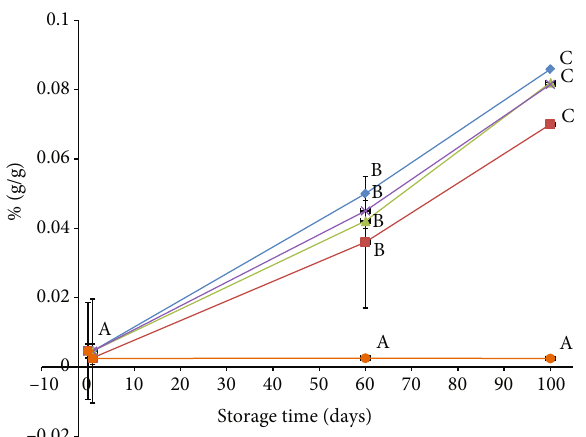
Figure 4: Melanin concentration (%) obtained by the di ff erent preservation methods during storage ( P value < 0.05). Control ( ♦ ), SO ( ● ), cold storage ( ▲ ), blanching three minutes ( ■ ), and 2 modi fi ed atmosphere packaging ( ╳ ). Same letter indicates no statistical di ff erences between groups.